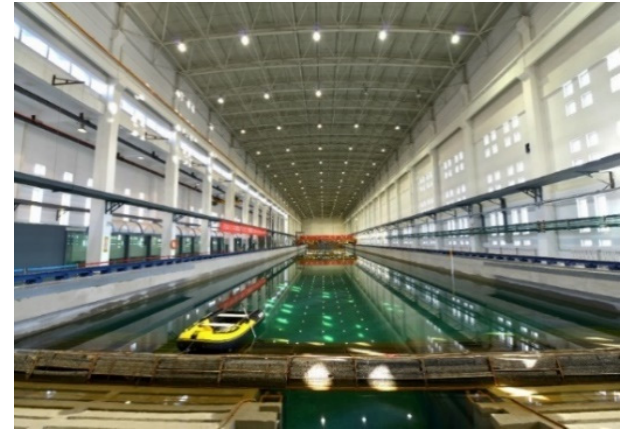
Figure 2. Multifunctional hydrodynamic laboratory of NOTC.